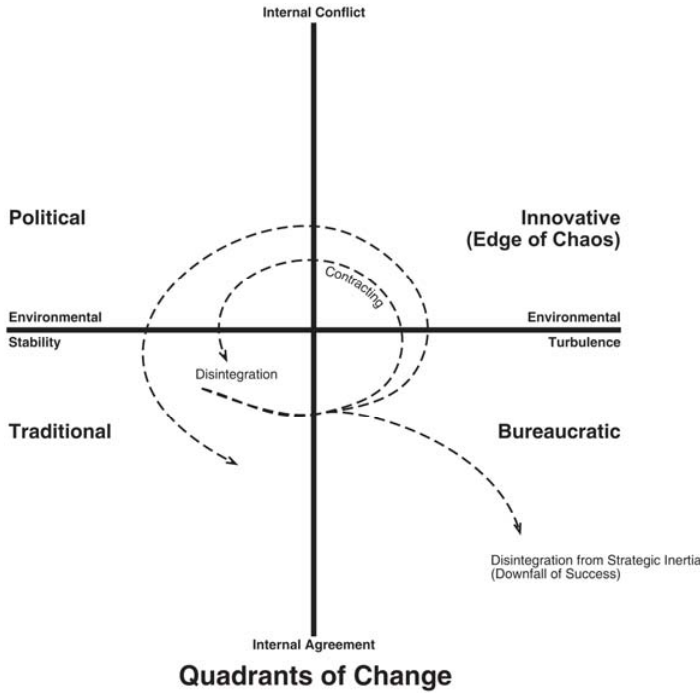
Figure 1: Dimensions of